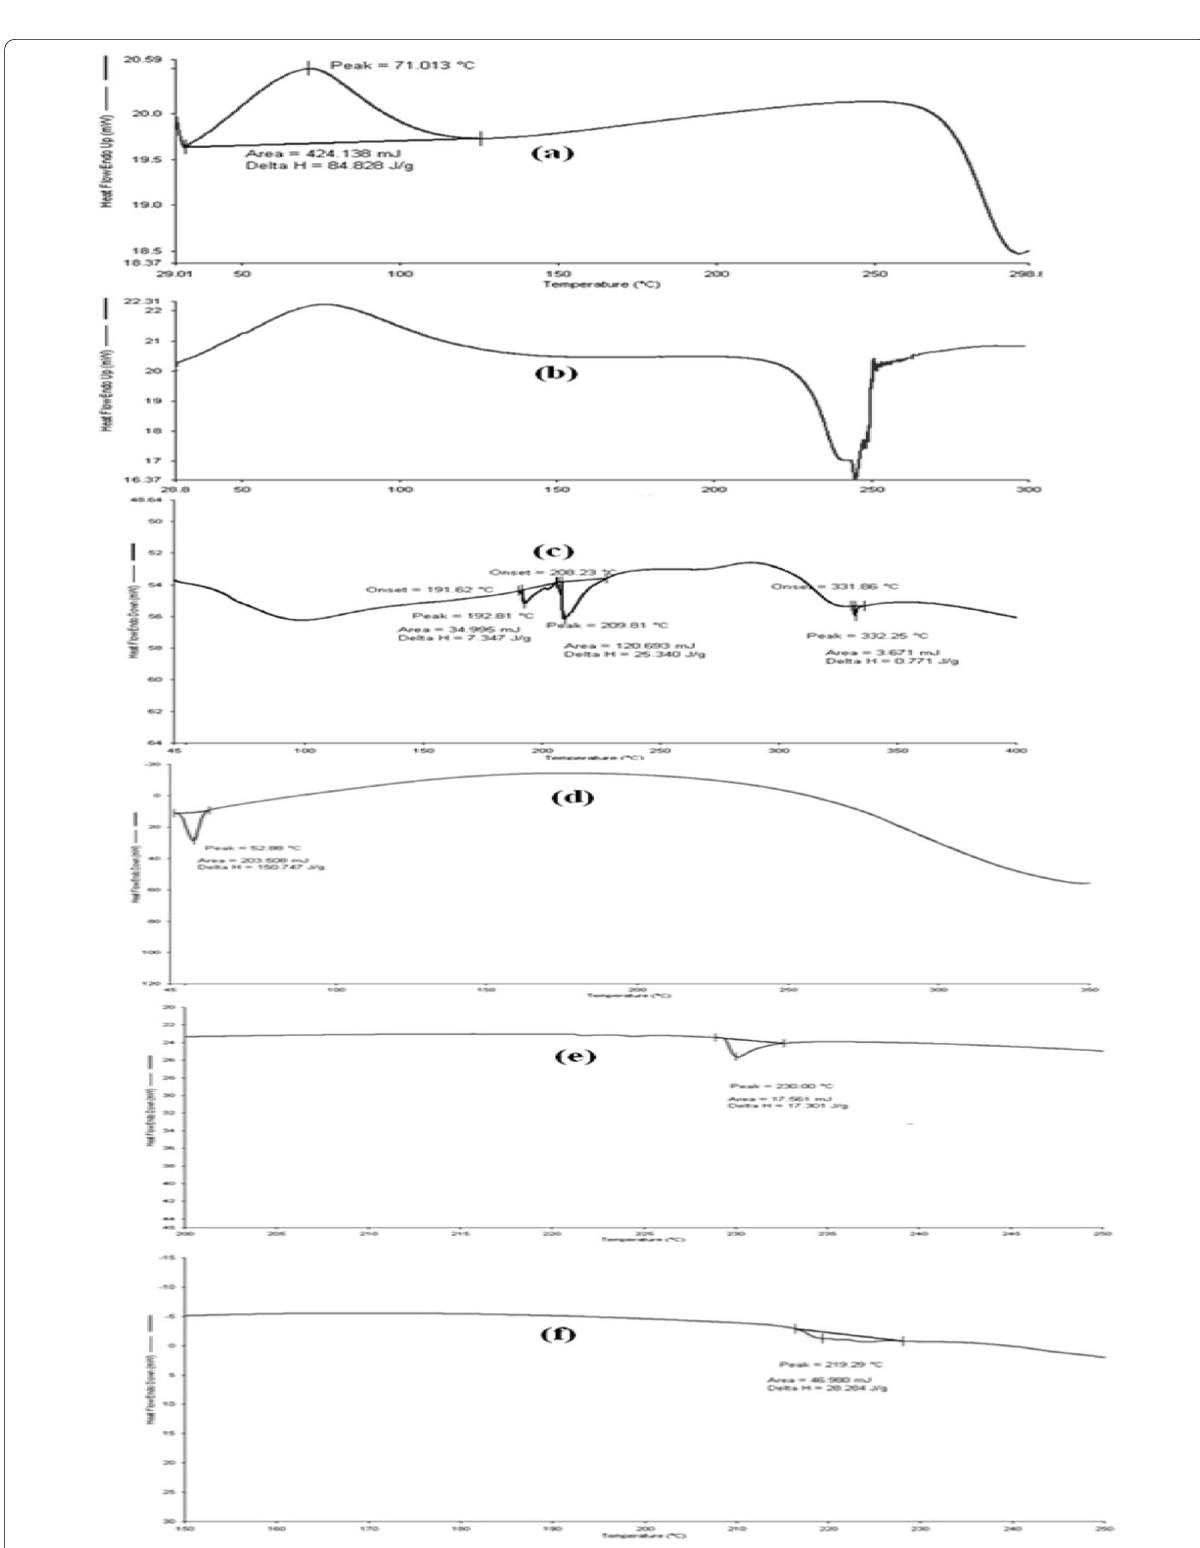
Fig. 1 DSC thermograms of Chitosan ( a ), Gellan gum ( b ), Gum Ghatti ( c ), Gum Karaya ( d ), dried blank Chitosan–Gellan Gum–Gum Ghatti PEC beads ( e ) and dried blank Chitosan–Gellan Gum–Gum Ghatti PEC beads ( f